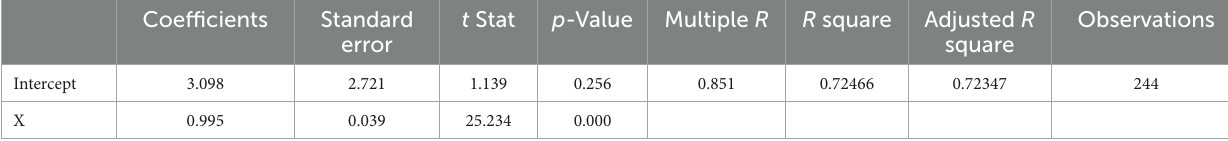
TABLE 4 The influence of the students’ mathematics problem-solving understanding on their mathematics learning results (linear